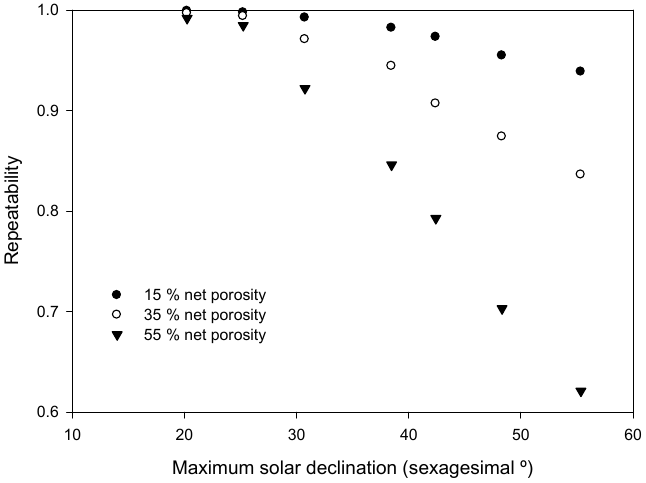
Figure 3. Repeatability depending on solar zenith angle and net porosity.